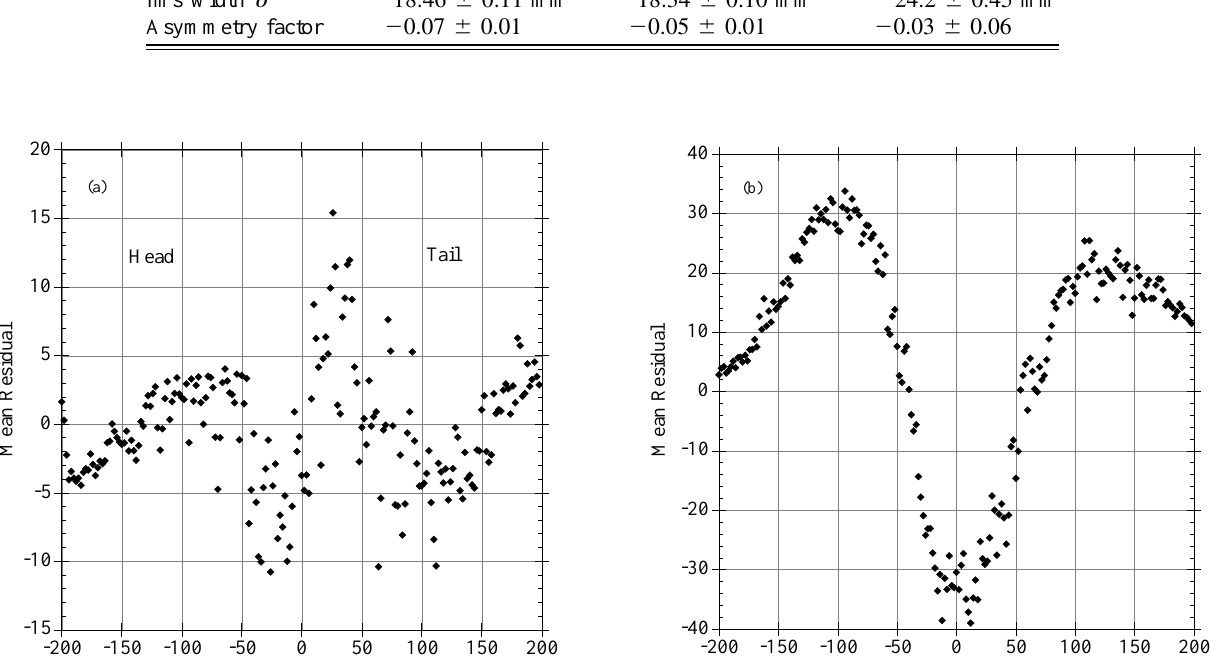
FIG. 14. The mean residual when the phase of the rf voltage was modulated at a voltage amplitude of (a) 2 20 dBm and (b) 1 10 dBm and frequency of 369.9 kHz. The head of the bunch is to the left of the center (zero on the plot) and the tail of the bunch is to the right of the